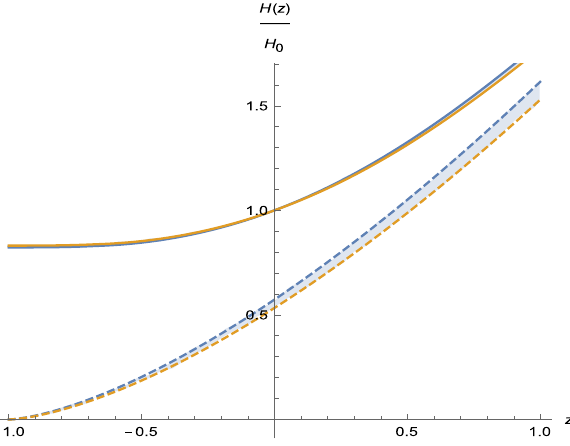
Fig. 1 Comparison between (cid:2) CDM model and non-zero torsion cos- mological